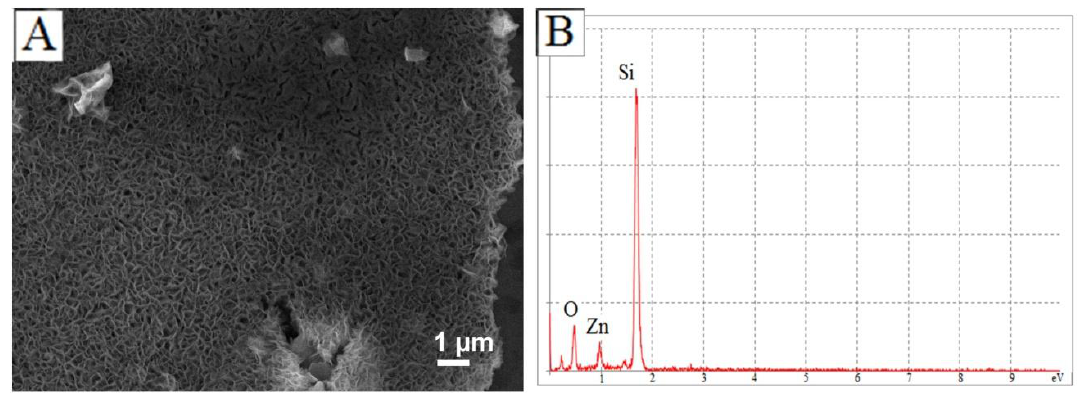
Figure 7. ( A ) SEM image of zinc silicate films generated after a period of three hours with microwave-assisted heating; ( B ) EDS confirms the chemical composition of the